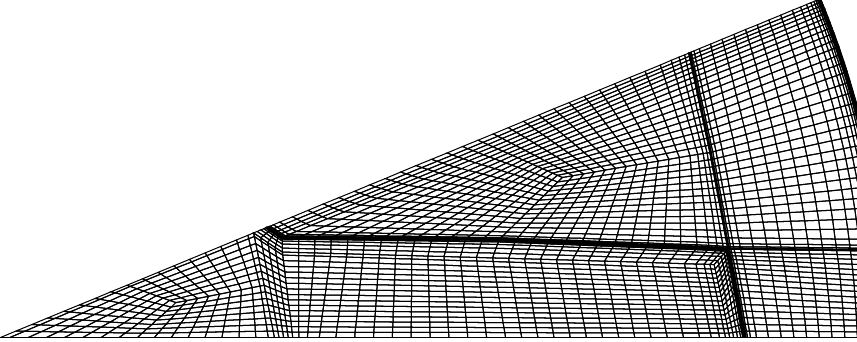
Figure 6. Mesh at the oxidizer inlet.